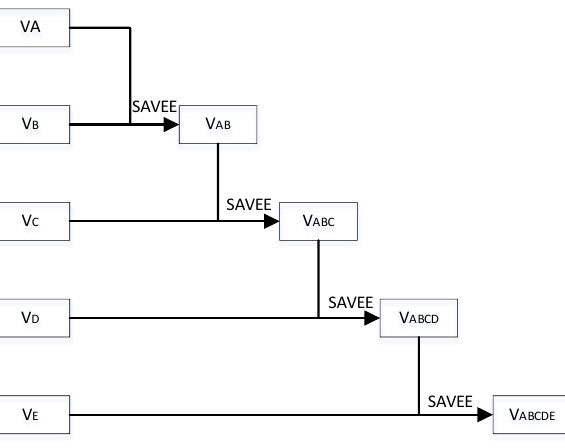
Figure 1. Flow of superposition equations in SAVEE calculation.